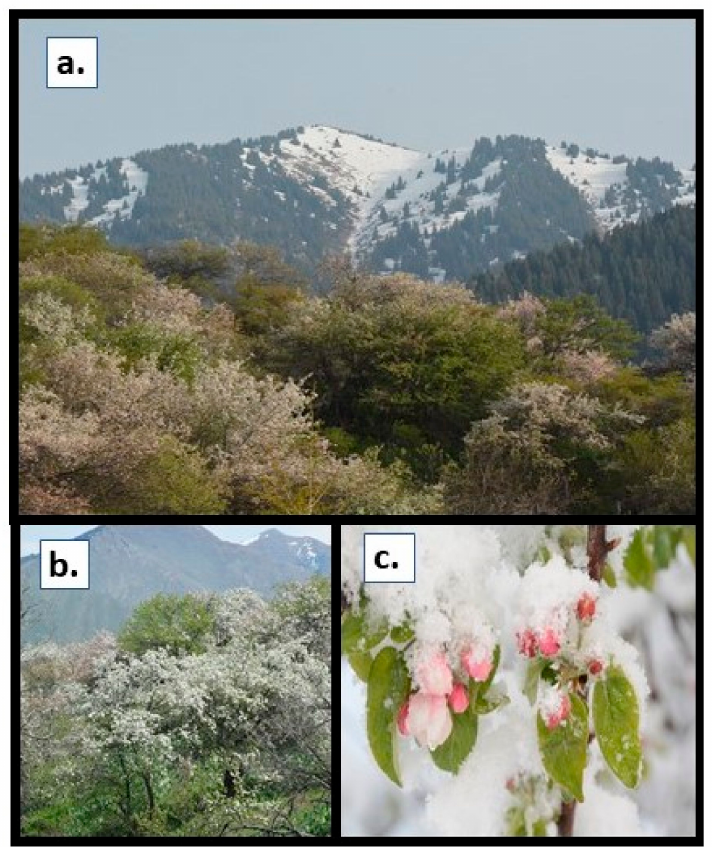
Figure 1. M. sieversii during spring, native range. ( a ) Montane habitat of Malus sieversii in Kazakhstan. ( b ) Natural occurrence of Malus sieversii on a hillside in Kazakhstan. ( c ) Bloom covered by sudden snow. Photos courtesy of Dr. Gayle Volk,